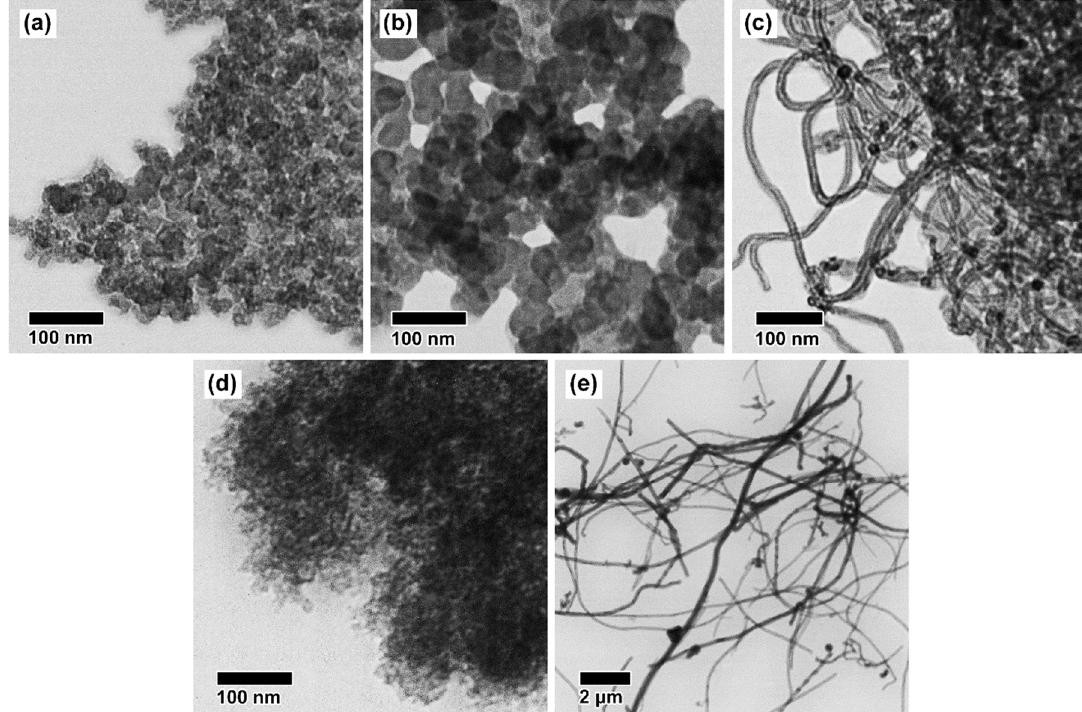
Figure 2. Representative TEM images of ( a ) CB BP, ( b ) CB V, ( c ) CNT, ( d ) MC, and ( e ) CNF materials.